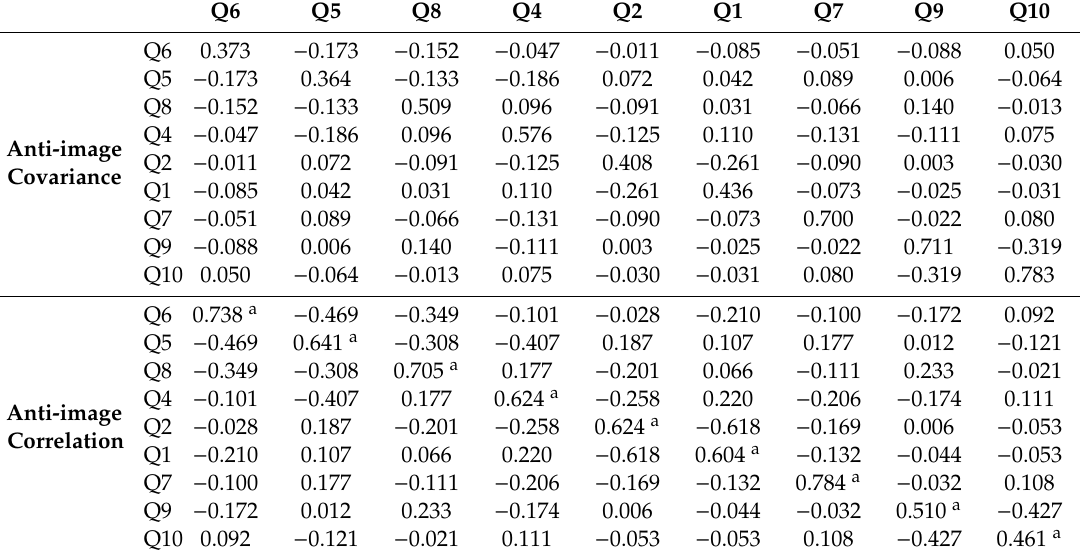
Table A2. Anti-image Matrices (N = 342).